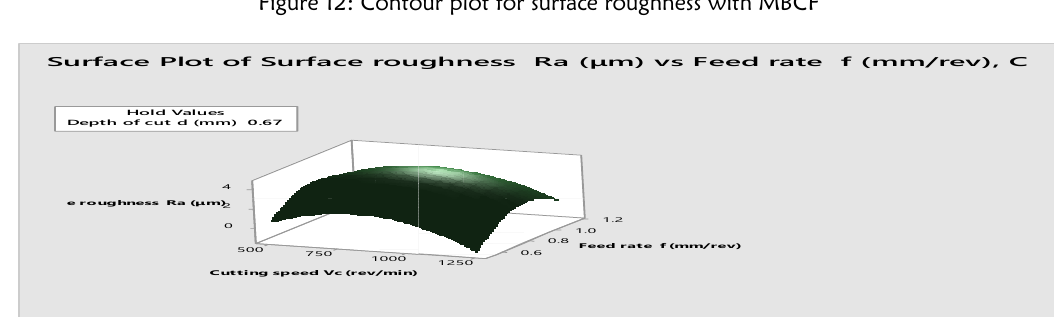
Figure 13: 3D surface graph for surface roughness with MBCF